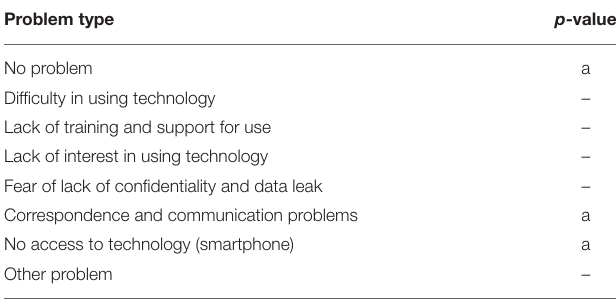
TABLE 6 | T -test results and comparison of the types of problems encountered in using the two platforms (no significant statistical difference